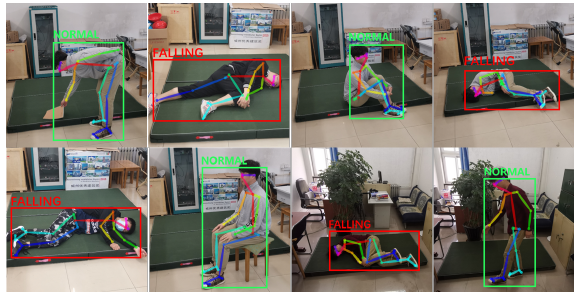
Fig. 9. Example of self-built dataset detection effect. and the corresponding skeleton information of